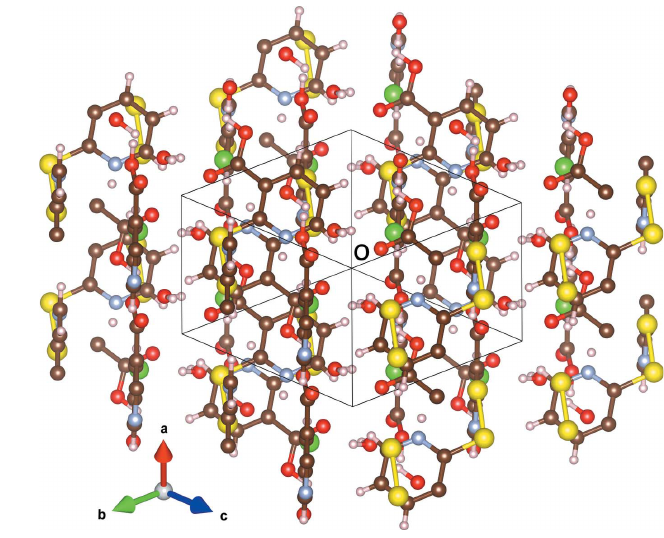
Figure 3 The view down [111], illustrating the inter-layer chloride and water sites which stitch the cationic dimers